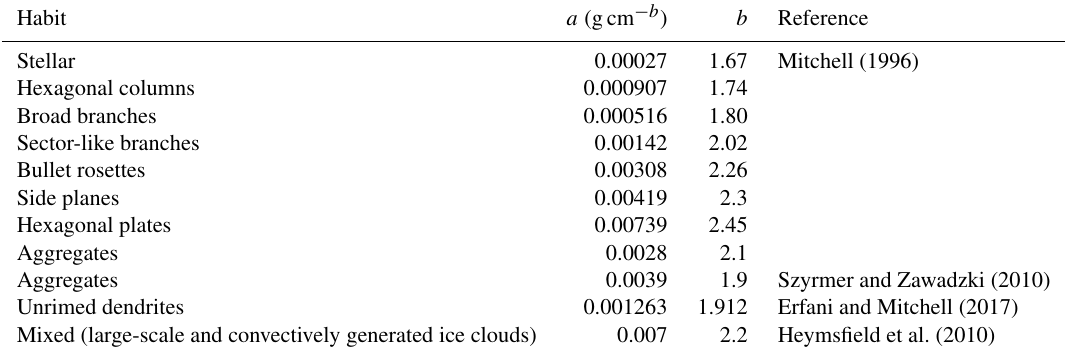
Table 2. Examples of mass–size relationships (taken from Mason et al., 2018). Habit